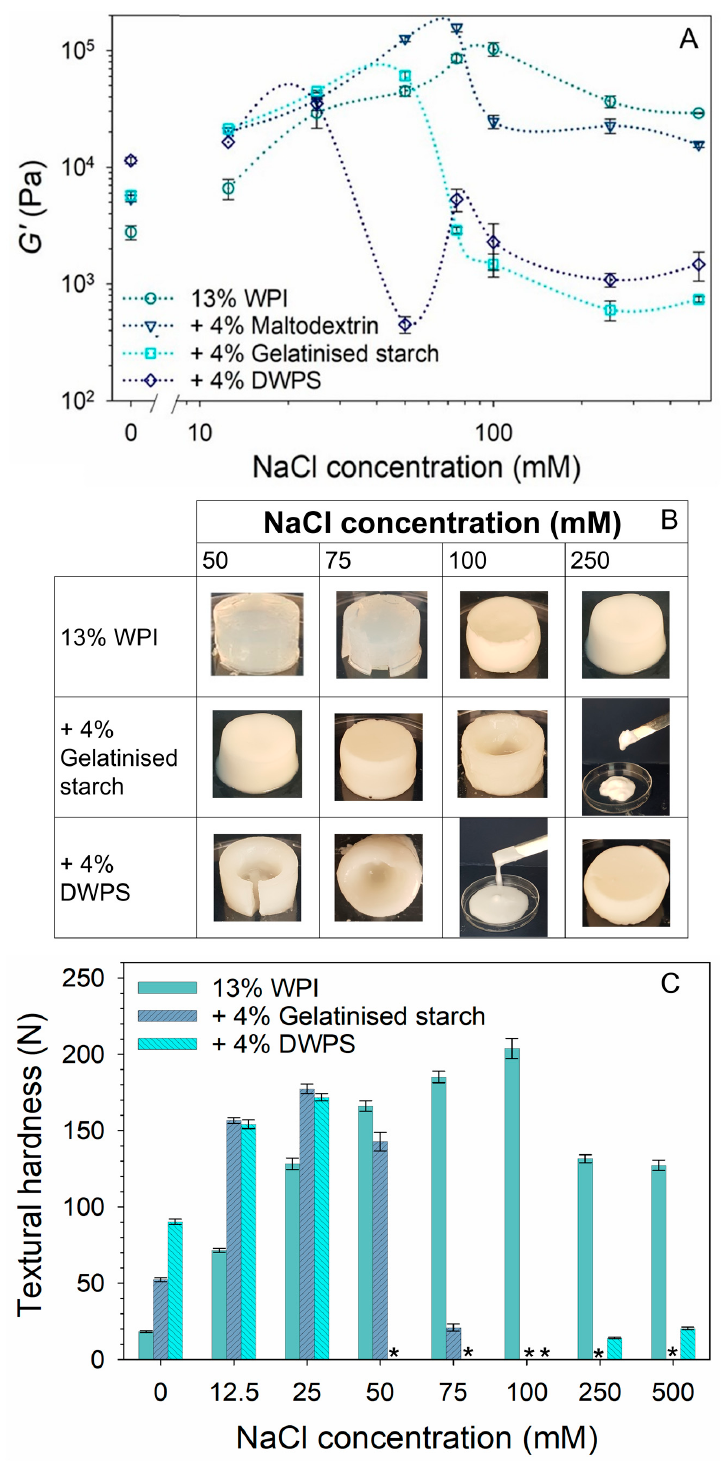
Figure 3. Effect of NaCl on the: ( A ) G (cid:48) from frequency sweep at 1% strain and 1 Hz frequency of 13% w / w WPI and 13% w / w WPI + 4% w / w maltodextrin, gelatinised starch, or DWPS with 0–500 mM NaCl at 20 ◦ C. Lines in the graphs serve as visual aids, ( B ) visual appearance of 13% w / w WPI and 13% w / w WPI + 4% w / w gelatinised starch or DWPS at 50, 75, 100, and 250 mM NaCl, ( C ) textural hardness of 13% w / w WPI and 13% w / w WPI + 4% w / w gelatinised starch or DWPS with 0–500 mM NaCl at room temperature. Values are plotted as means ± standard error. Note that compression test was not performed on inhomogeneous/paste-like gels (denoted with